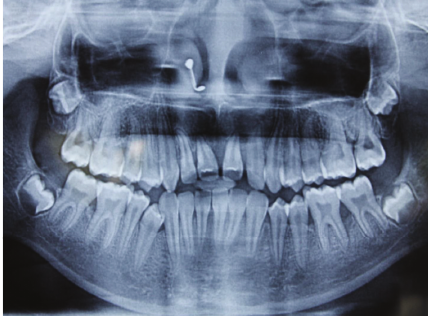
Figure 4: Intraoral picture showing maxillary arch with spacing of teeth between 11, 12, 13, 21, 22, and 23.